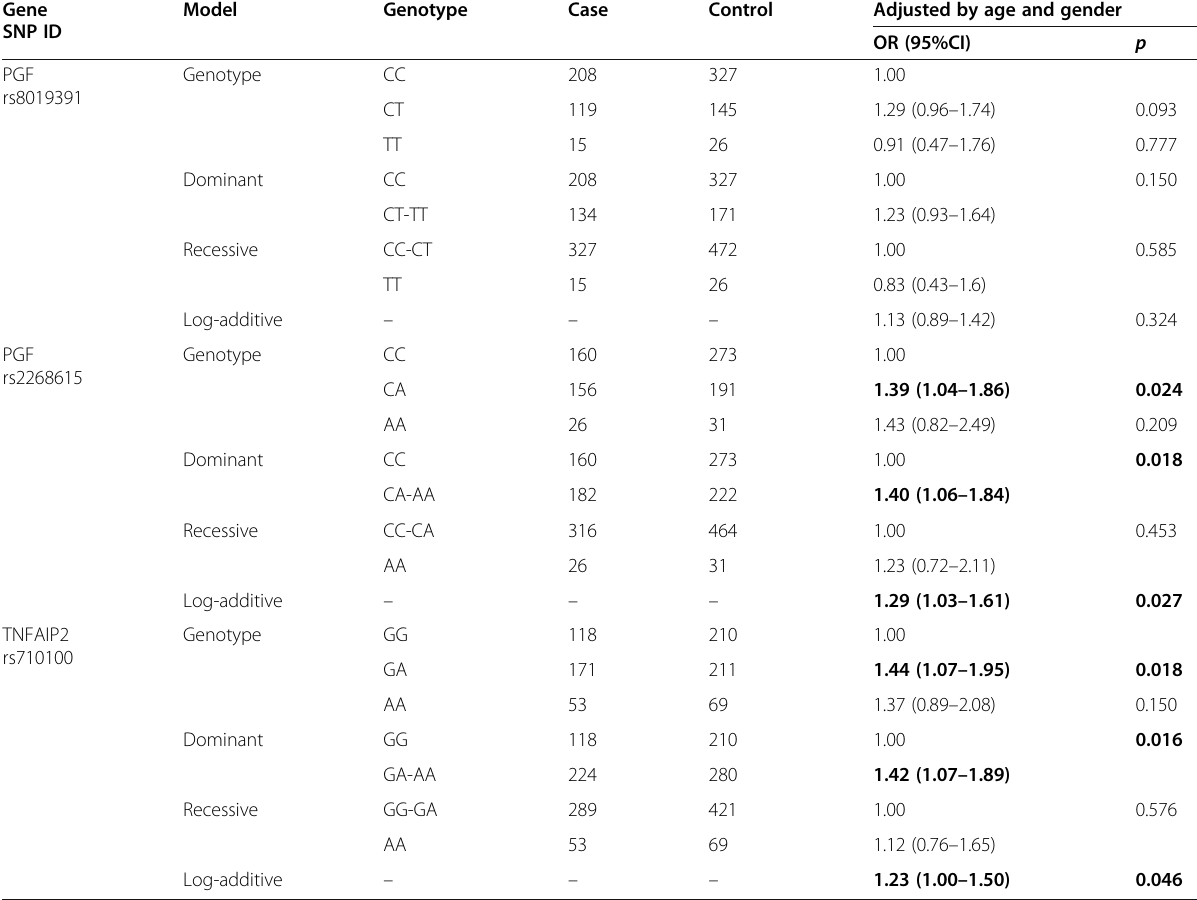
Table 2 Relationships between the candidate SNPs and cervical cancer risk Gene SNP